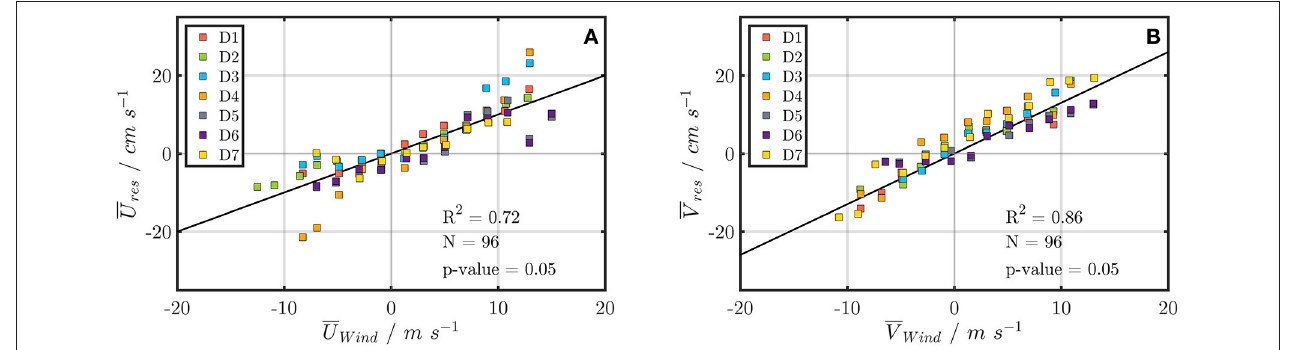
FIGURE 10 | Bin-averaged residual drifter zonal (A) and meridional (B) velocities as a function of the bin-averaged wind speed for every drifter separately. The slope of the fit in (A) is 1 and shows the bin-averaged zonal velocity as a function of the zonal wind speed component with squared correlation of R 2 = 0.72 and p = 0.05. The slope of the fit in (B) is 1.3 and shows the bin-averaged meridional velocity as a function of the meridional wind speed component with squared correlation of R 2 = 0.86 and p =